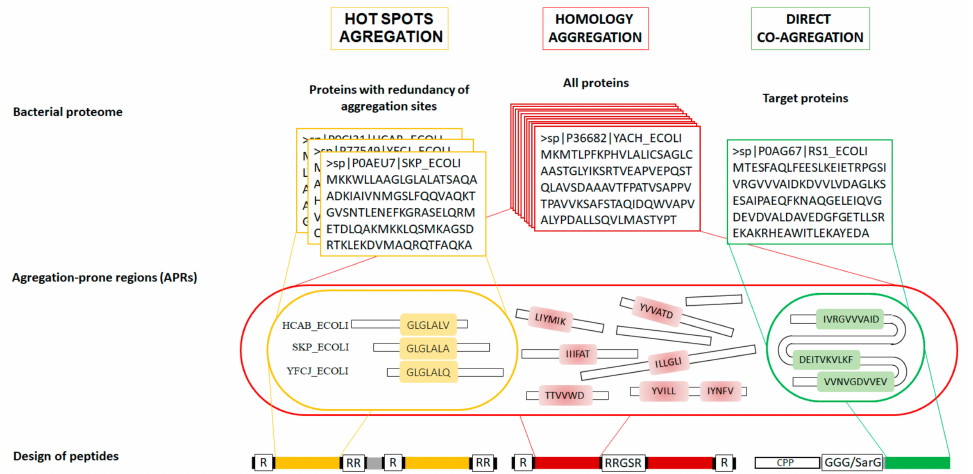
Figure 1. Strategies for the development and design of amyloidogenic antimicrobial peptides include three steps: selection of a list of protein sequences, search in the list of APRs, and construction of a peptide. The homologous aggregation (red color) strategy [1] involves searching for APRs in the entire set of bacterial proteins. A peptide designed in this way consists of a duplicate section of APRs separated by a glycine–serine linker and flanked by arginine and lysine to maintain colloidal stability. The hot spot aggregation (yellow color) strategy [32] involves searching for the most common APRs in the bacterial proteome. A peptide designed in this way represents a duplicated section of APRs flanked by arginine at the ends of the sequence and separated by a proline linker. The direct co-aggregation (green color) strategy involves the preliminary selection of a target protein and the search for APRs in it. An amyloidogenic site conjugated to a CPP sequence separated by a GGSarG or GGGG type